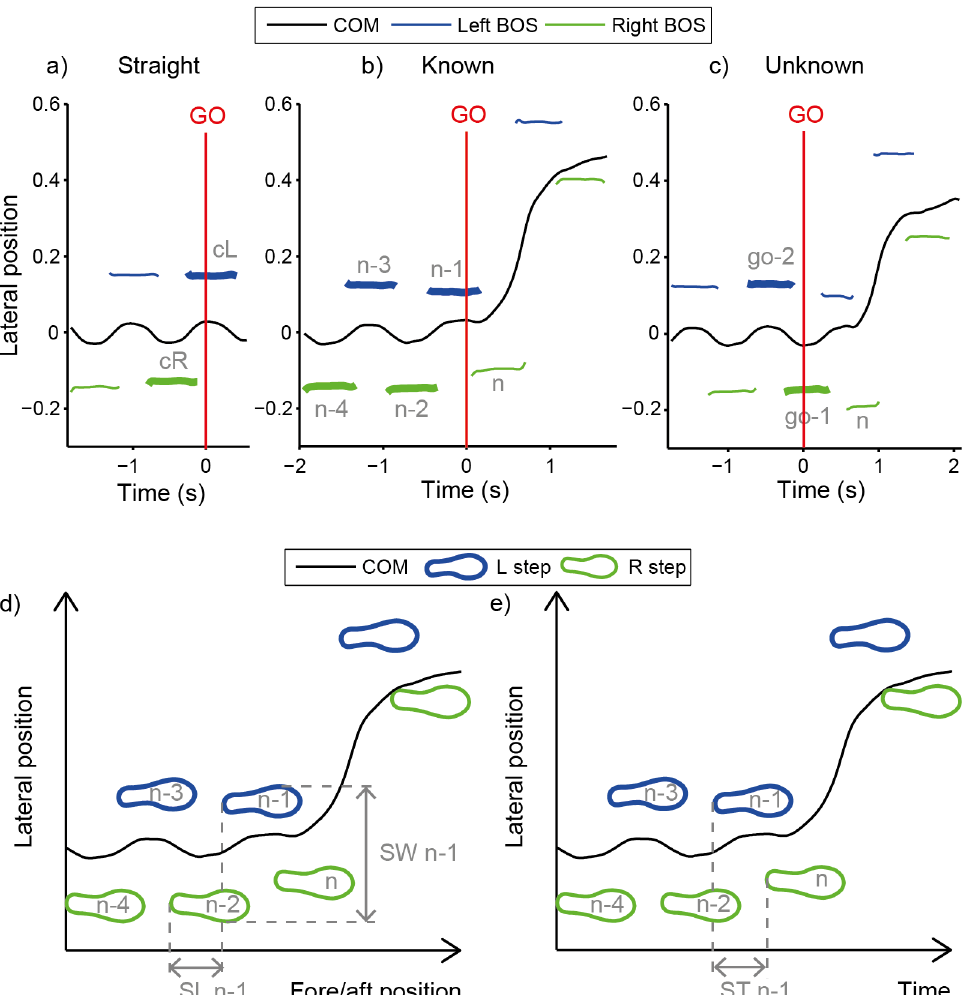
Fig 2. Step Analysis. Representative data from a single subject of center of mass (COM) and left and right base of support (BOS) position before and after the “ GO ” signal during each condition. a) Straight. “ cL ” and “ cR ” denote control left and right steps used for analysis. b) Known left. “ n ” denotes the maneuver step. The four steps prior to the n step, the n-1 through n-4 steps, were analyzed for specific anticipatory behavior. c) Unknown left. For this condition only, the “ GO ” signal denotes when subjects learned the maneuver direction. The two steps initiated prior to the “ GO ” signal, the go-1 and go-2 steps, were analyzed for general anticipatory behavior. The “ n ” or maneuver step is also shown for reference. d) Determination of step width (SW), and step length (SL) for the n-1 step of a Known left example trial. Step width for the n-1 step was calculated as the medio-lateral distance between the two 5 th Metatarsal markers at the n-1 initial contact. Step length for the n-1 step was calculated as the fore-aft distance between the two 5th Metatarsal markers at the n-1 initial contact. e) Determination of step time (ST). Step time for the n-1 step was calculated as the time between the n-1 and n step initial contact